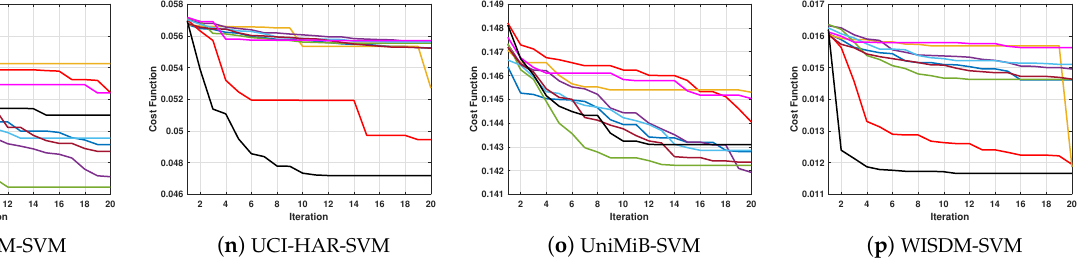
Figure 4. Convergence curve for applied MH optimizers for each studied dataset using RF and SVM classifiers.